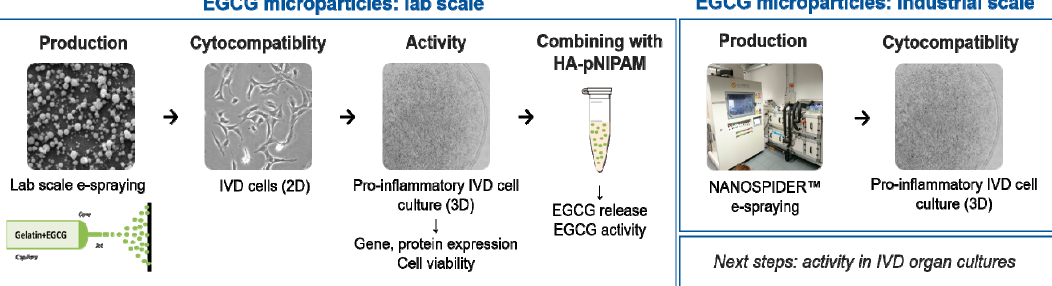
Figure 1. Experimental workflow. The polyphenol epigallocatechin 3-gallate (EGCG) microparticles were produced by electrospraying (e-spraying) and their cytocompatibility was tested in intervertebral disc (IVD) cells cultured in 2D. The activity of EGCG microparticles was tested in pro-inflammatory IVD cell cultures utilizing 3D alginate beads treated with 5 ng/mL IL-1 β for seven days. Next, the particles were combined with a thermoreversible HA-pNIPAM carrier and the activity and release of EGCG were measured. Then, the production of EGCG microparticles was upscaled and cytocompatibility of the resulting particles was measured in the pro-inflammatory IVD cell cultures, utilizing 3D alginate beads treated with 5 ng/mL IL-1 β for seven days.